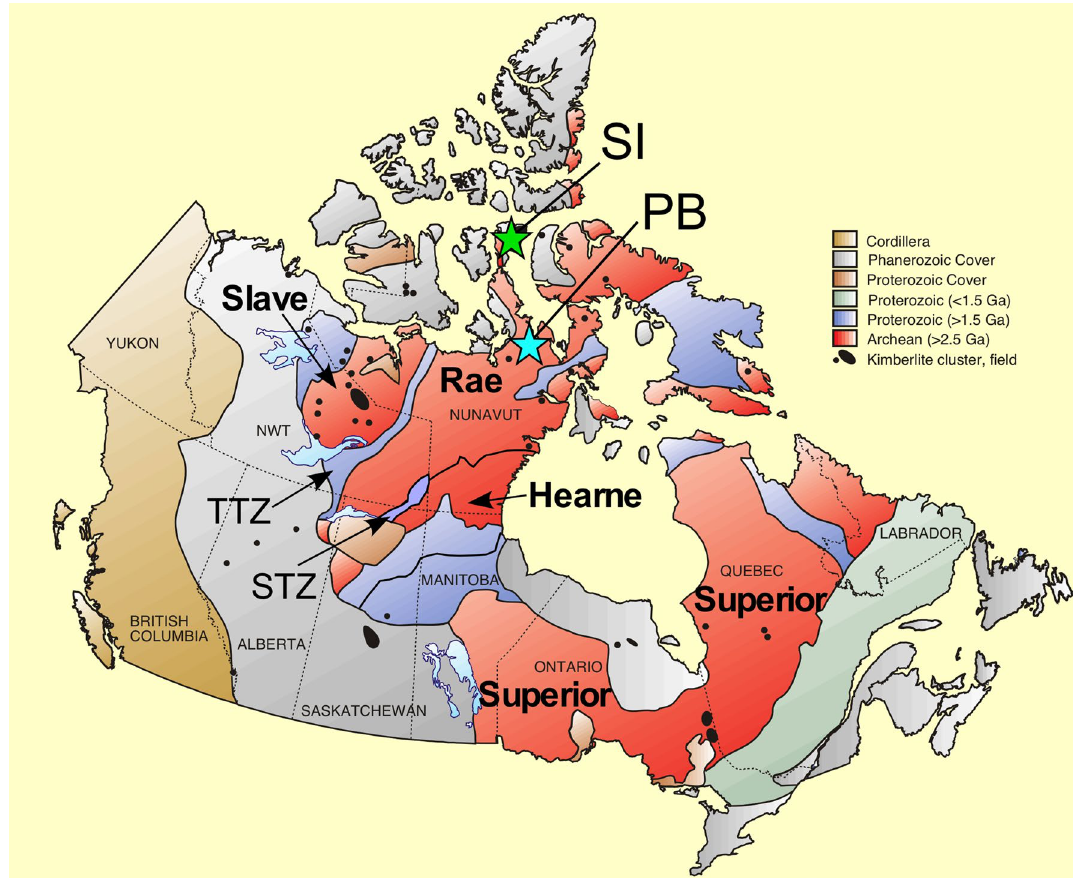
Figure 1. Schematic map of the Canadian shield illustrating the peridotite xenolith localities along with the constituent cratonic blocks and surrounding tectonic zones. SI Somerset Island, PB Pelly Bay, TTZ Thelon– Taltson magmatic zone, STZ Snowbird tectonic zone (modified after Kjarsgaard 13